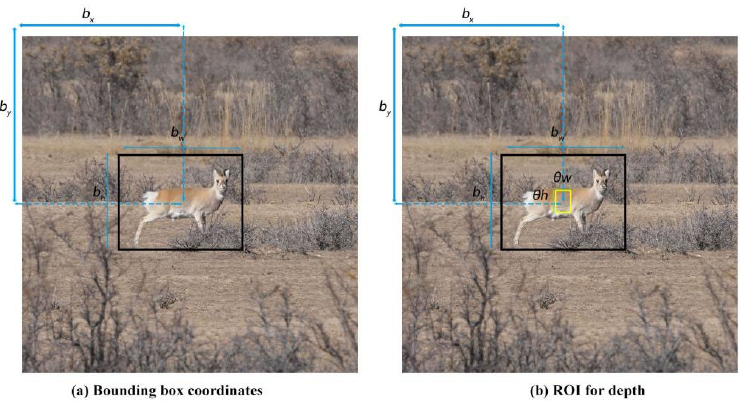
Figure 6. ( a ) Bounding box coordinates; ( b ) ROI for depth.